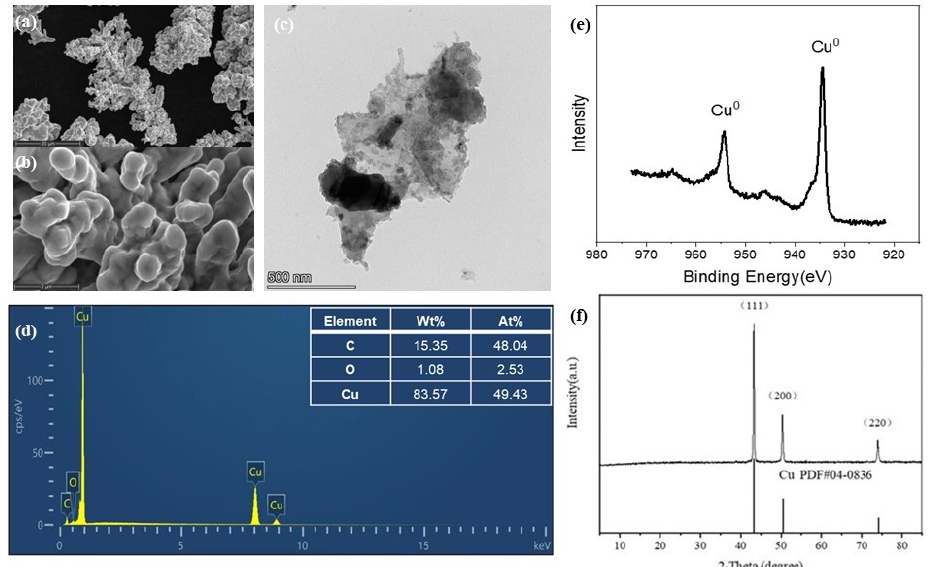
Figure 1. SEM ( a , b ), TEM ( c ), EDX ( d ), XPS ( e ) and XRD ( f ) of the catalyst.